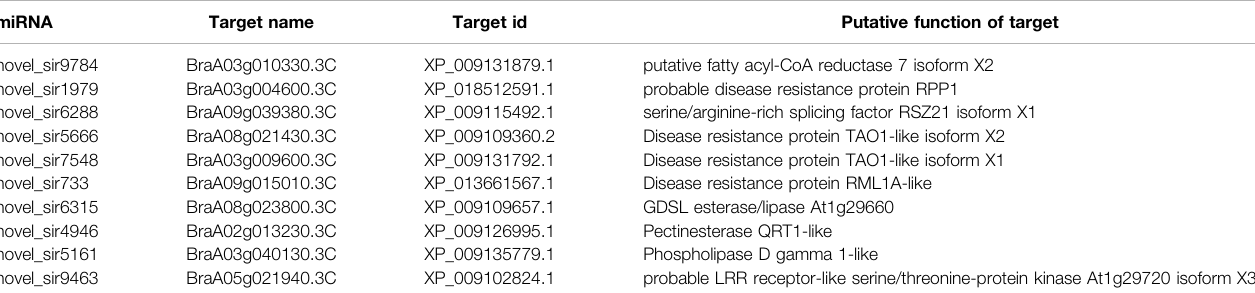
TABLE 1 | Potential target genes of differentially expressed novel siRNAs in fl owering Chinese cabbage under heat stress.